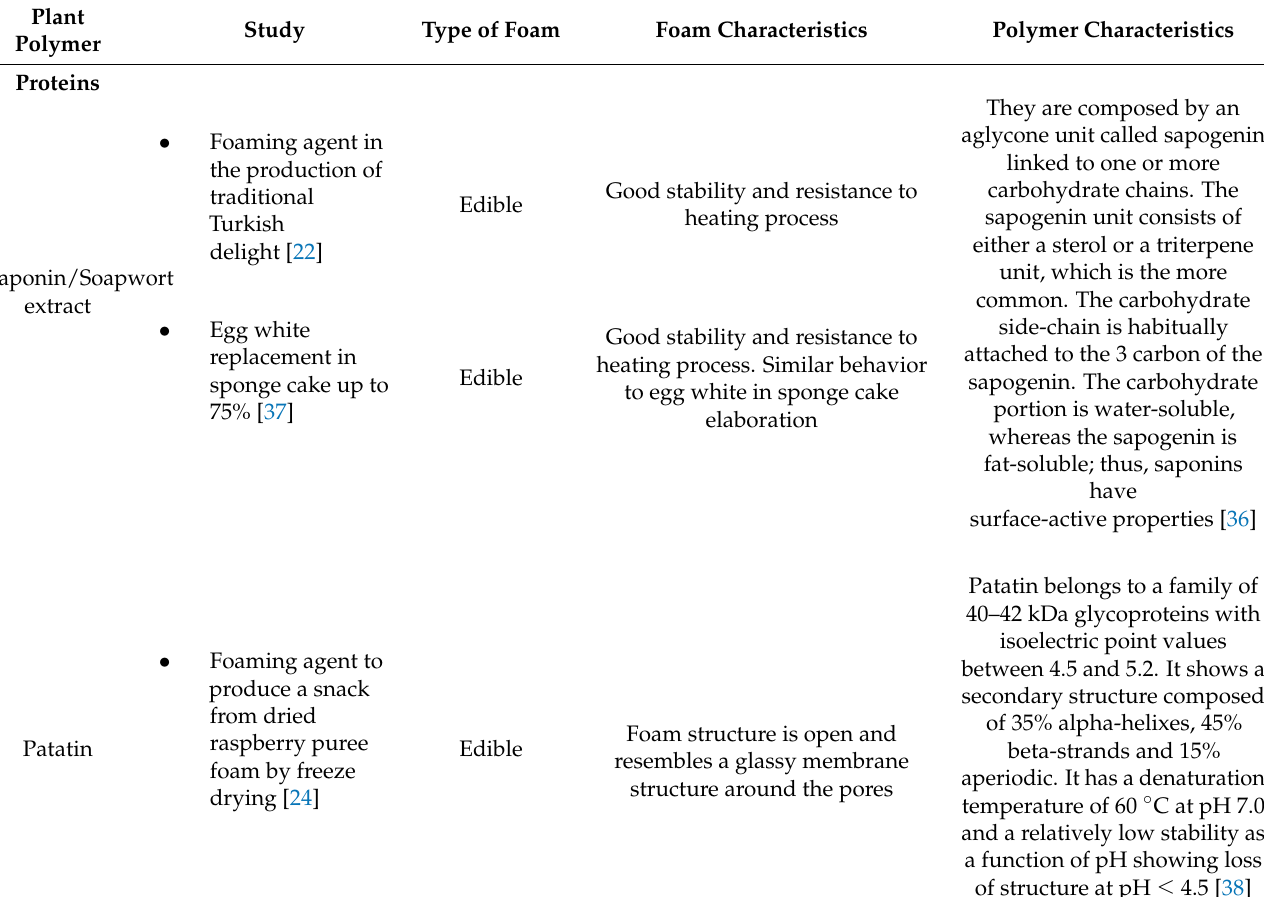
Table 1. Studies for food industry applications of plant polymesr-based solid